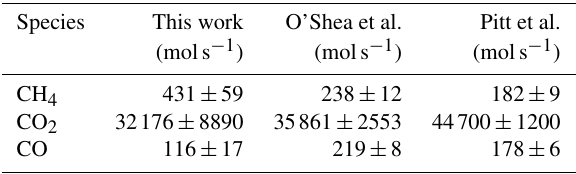
Table 2. Emission fluxes from Greater London determined in this study and compared to those found using similar approaches by O’Shea et al. (2014a) and Pitt et al. (2019). Species This work O’Shea et al. Pitt et al. (mols − 1 ) (mols − 1 ) (mols − 1 ) CH 4 431 ± 59 32176 ±